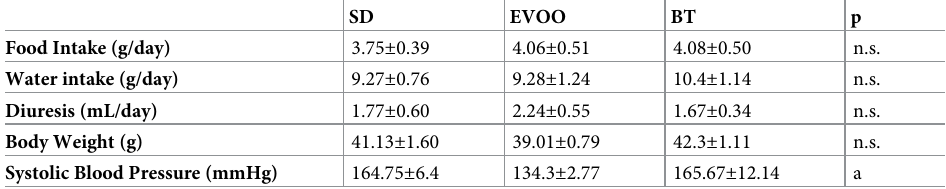
Table 1. Physiological responses of mice after six weeks of